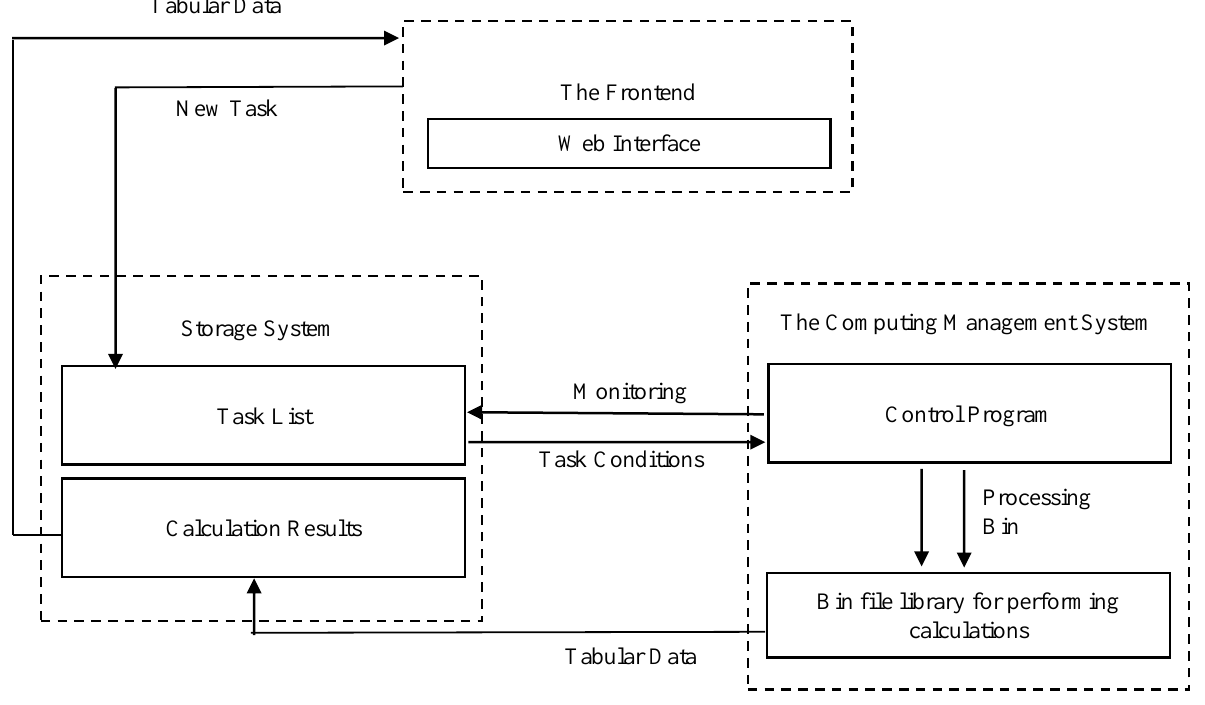
Figure 3. A conceptual scheme of the remote computing management